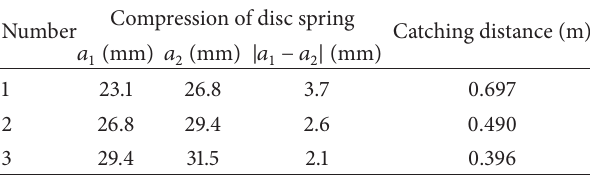
Table 9: Catching distance of antifalling safety device